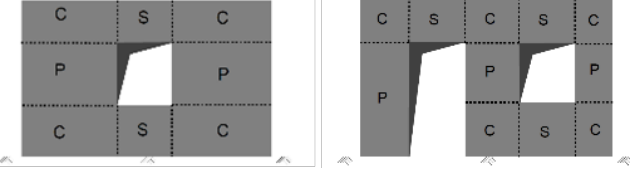
Figure 3. Panel definitions for URM walls of Type 1 ( left ) and Type 3 ( right ).